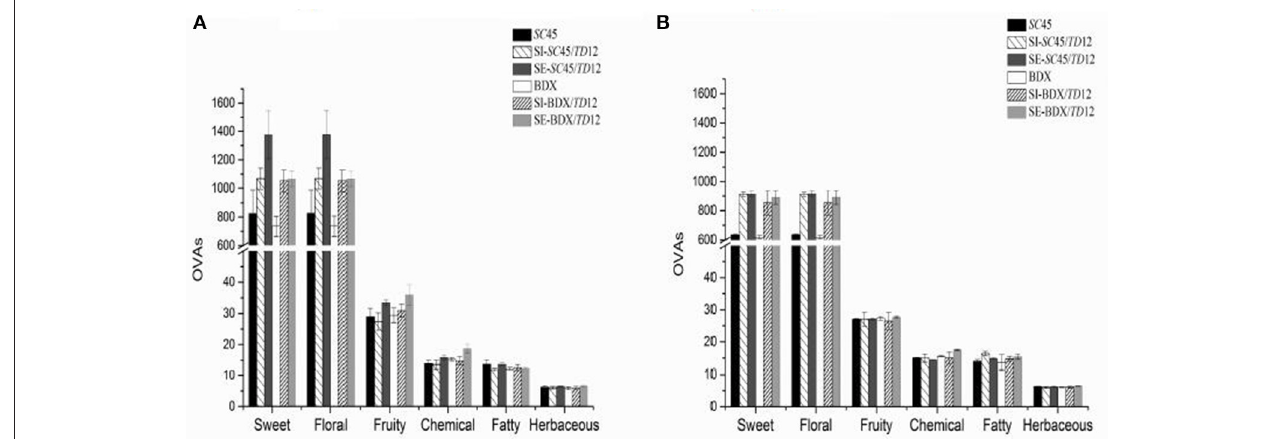
FIGURE 3 | Aroma series in final wines produced by SC 45 or BDX pure fermentation, simultaneous and sequential co-fermentation with TD 12 after alcoholic fermentation (A) and malolactic fermentation (B) , respectively. Error bars represent standard deviations. Aroma compounds are used and calculated for floral series: 1-octanol, phenylethyl alcohol, citronellol,phenylacetaldehyde; for fruity series: 1-octanol, ethyl butanoate,isoamyl acetate,ethyl hexanoate,ethyl decanoate,ethyl acetate,geraniol;for sweet series: phenylethyl alcohol,phenylacetaldehyde; for herbaceous series: 3-methyl-1-pentanol, 1-hexanol, (Z)-3-hexen-1-ol, geraniol, decanal; for chemical series; 3-methyl-1-butanol, 3-methyl-1-pentanol; 1-octen-3-ol, ethyl acetate, 4-ethyl-phenol; for fatty series: (Z)-3-hexen-1-ol, hexanoic acid, octanomic acid,decanoic acid, 4-ethyl